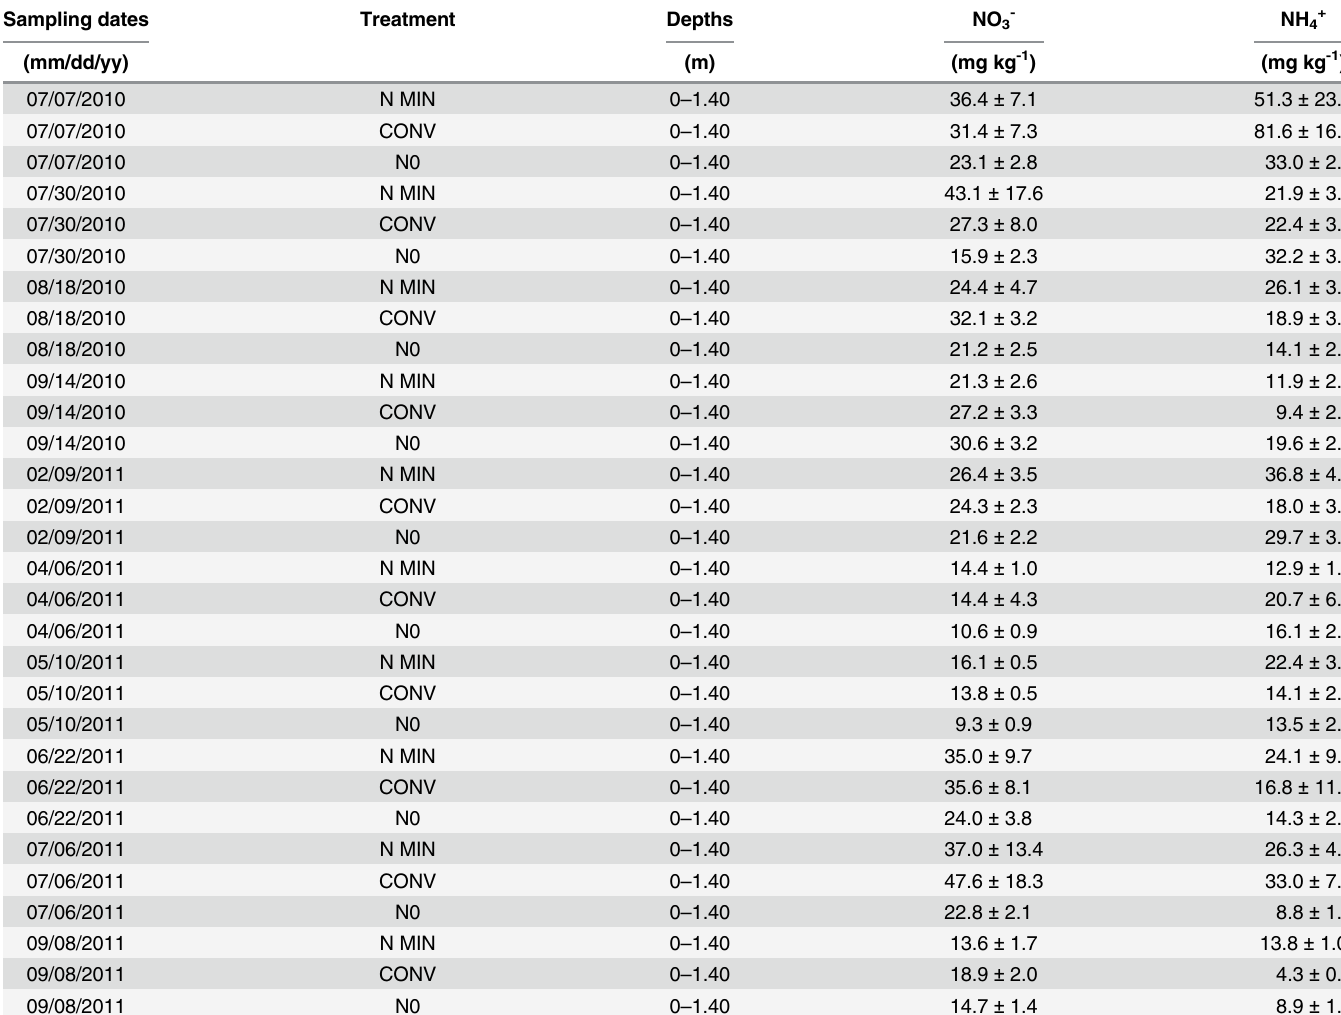
Table 6. Measured means and standard errors of nitrate and ammonium soil profile content during the maize-triticale-maize rotation for the N MIN, CONV and N0 treatments (n = 3). Values of the eight soil depths were averaged for each sample and the standard errors calculated for the three replicates. Dates are reported as